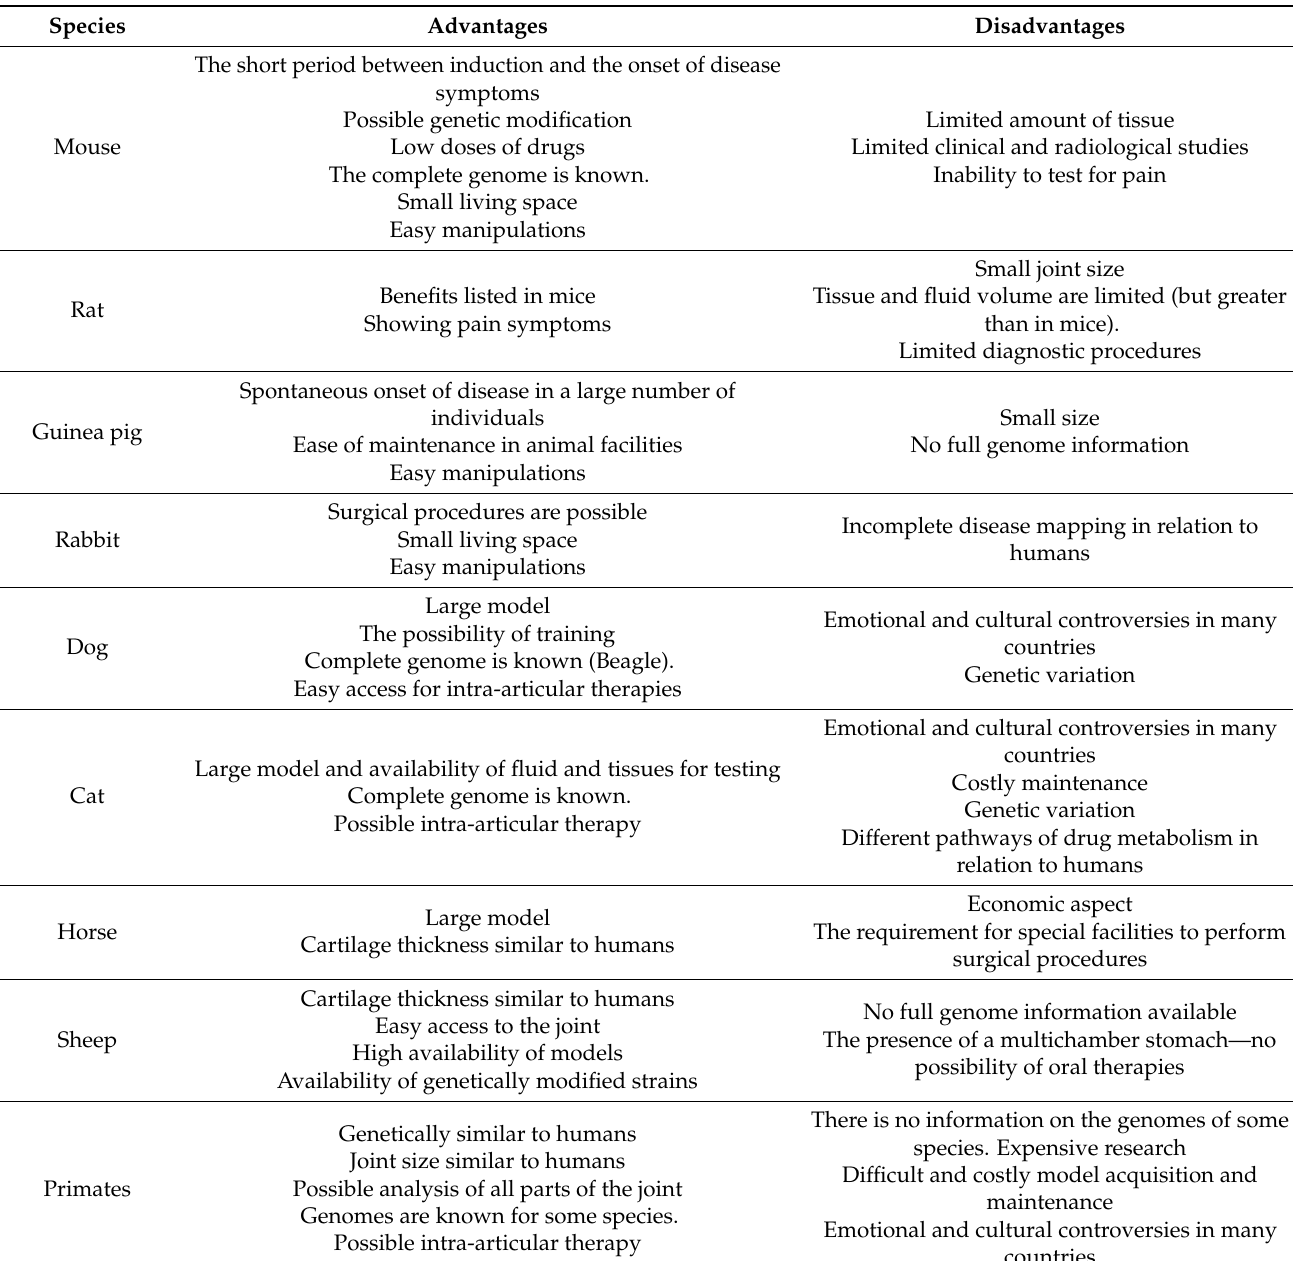
Table 1. Summary of the advantages and disadvantages of the most popular types of animal